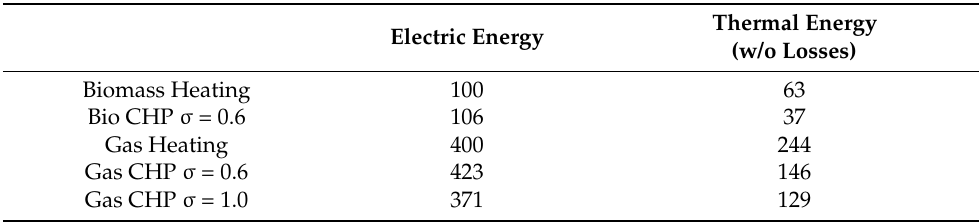
Table 8. CO 2 conversion factor f CO2 for electricity and DH (thermal); Remark: if 10% losses of the DH system are assumed the CO 2 conversion factor of gas would increase to f CO2,th = 288 g/kWh th . In the following calculation, the losses are included in the generated